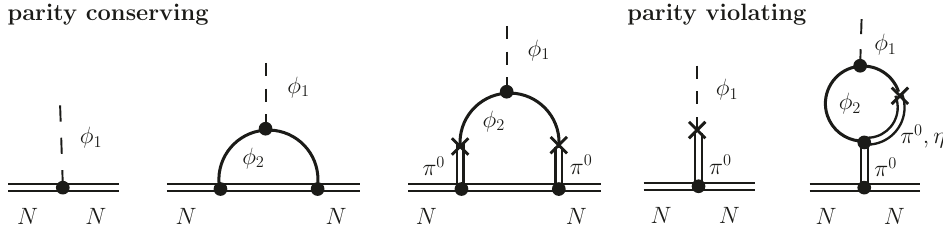
Figure 11 . The leading order and one loop induced (cid:30) 1 -couplings to nucleons grouped into parity conserving coupling g 1 NN (even in g A ) and parity violating coupling ~ g 1 NN in (3.61) (odd in g A ). The 3rd diagram is the only non-vanishing contribution to g 1 NN in BM2.